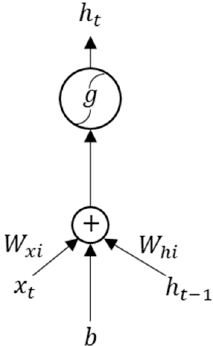
Figure 2. An example of a simple recurrent neural network (RNN).